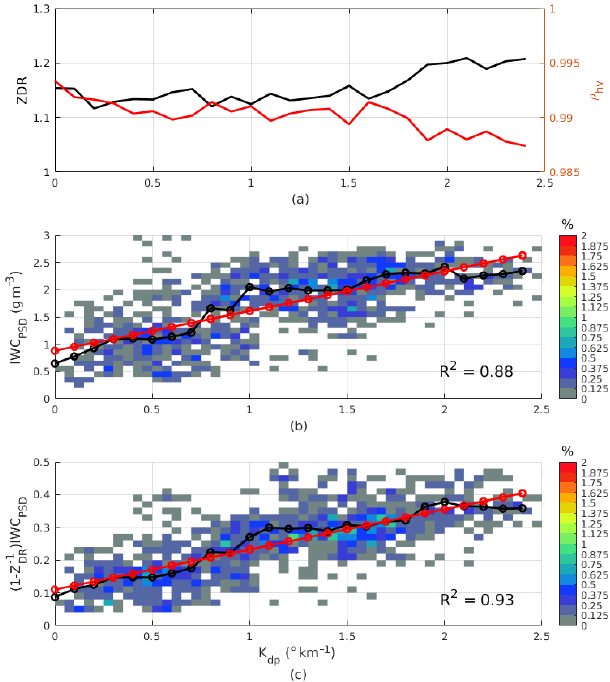
(cid:16) (cid:17) 1 − Z − 1 IWC (c) as DR